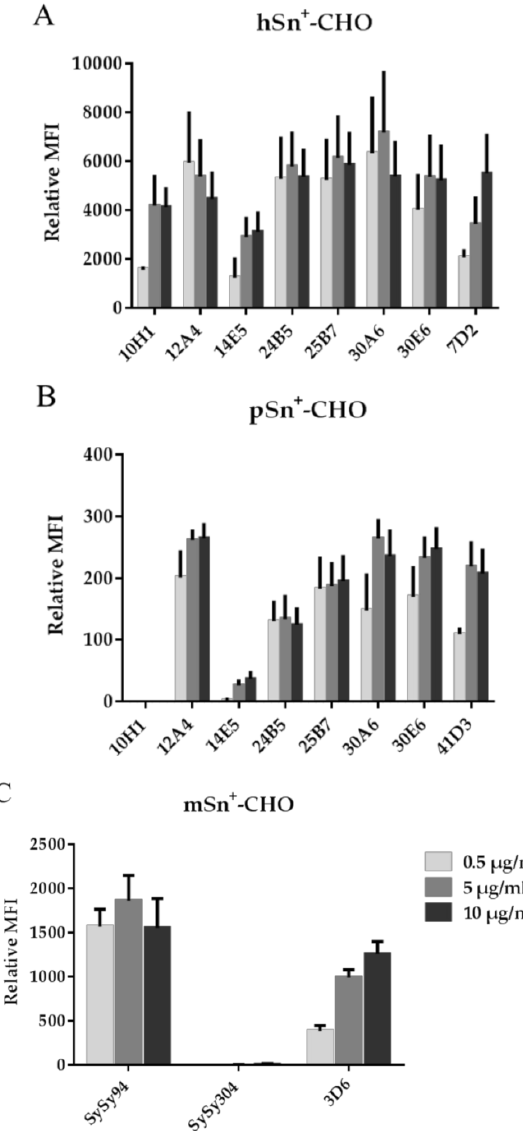
Figure 2. Flow cytometric analysis of mAbs binding to Sn + -CHO cells. Different concentrations of mAbs were added to CHO cells expressing ( A ) hSn; ( B ) pSn; and ( C ) mSn, followed by secondary fluorescently-labeled Ab. Surface staining was measured only on living cells by excluding dead cells using propidium iodide (PI). Data represents the relative mean fluorescence intensity (MFI) and standard error of the mean of three independent repeats.